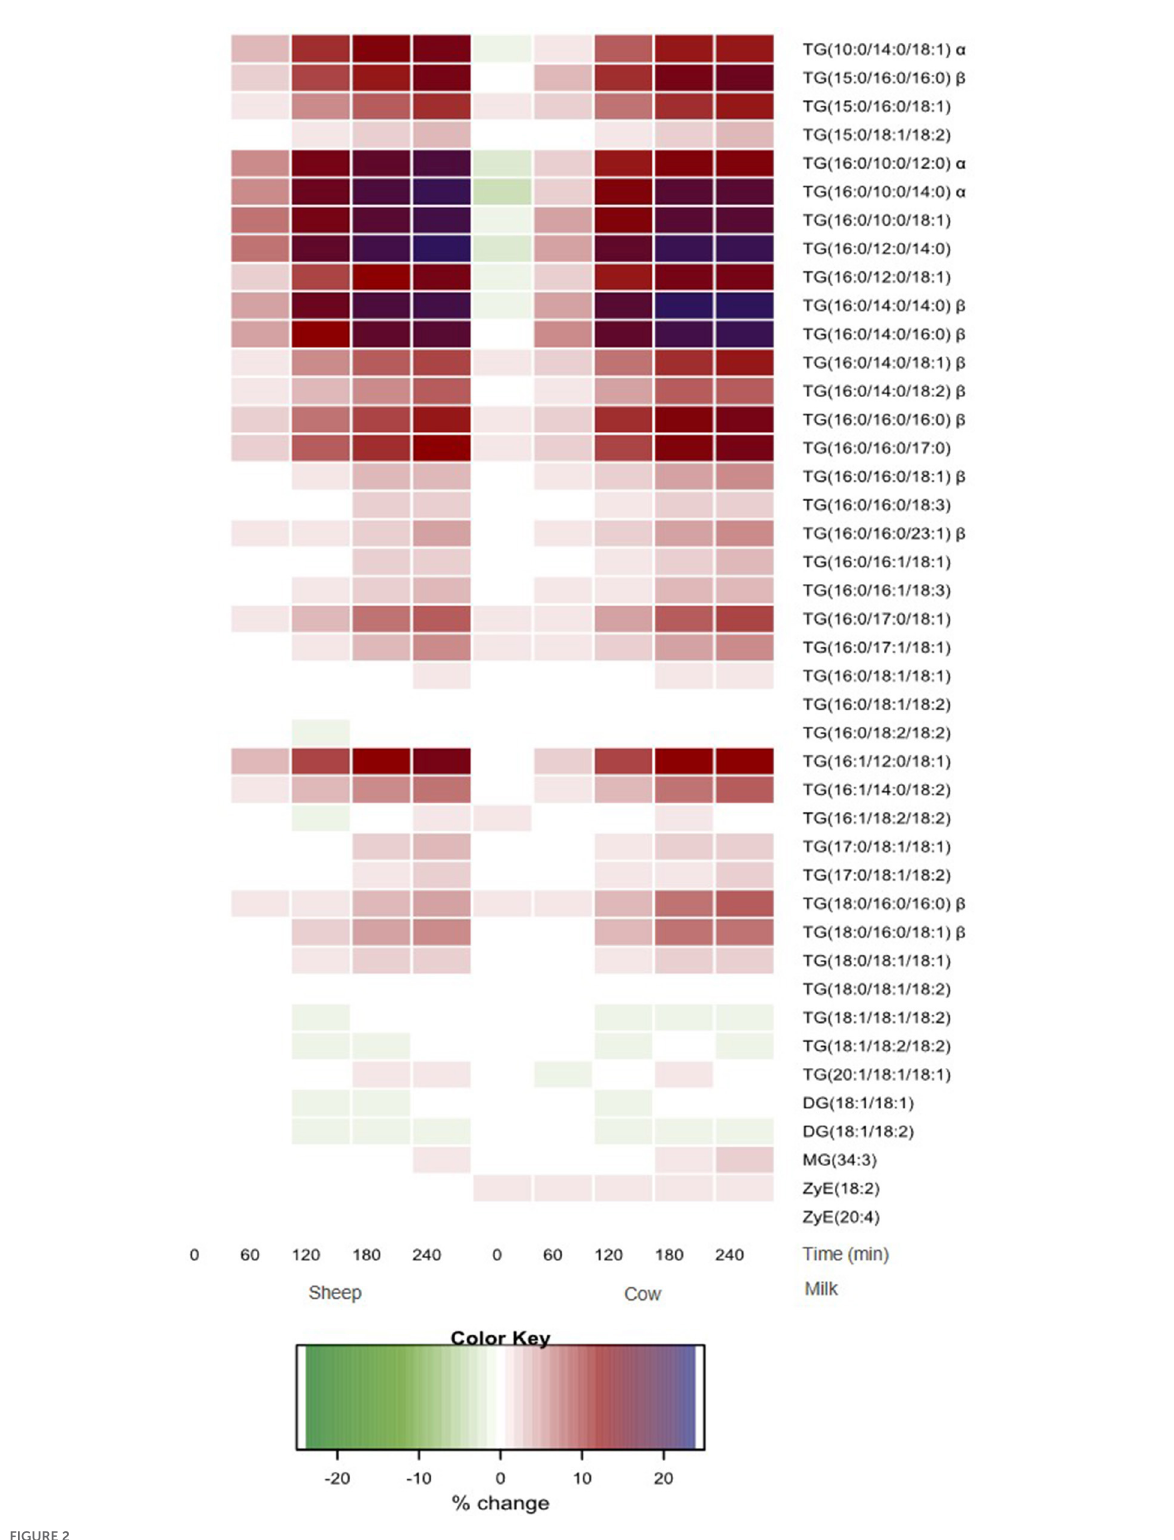
FIGURE2 Heatmap of postprandial changes in individual TG, DG, MG and ZyE species. Values are presented as mean log fold% changes relative to concentrations at fasting SM (0min); white represents a 0% change from SM baseline; red represents a 12.5% increase; blue represents and 25% increase; green represents a decrease; α denoted interaction time × milk with postprandial SM abundance greater than CM ( p < 0.05), while β denoted postprandial CM abundance is greater than SM ( p < 0.05). SM, sheep milk; CM, cow milk; TG, triglyceride; DG, diglyceride; MG, monoglyceride; ZyE, Zymosteryl